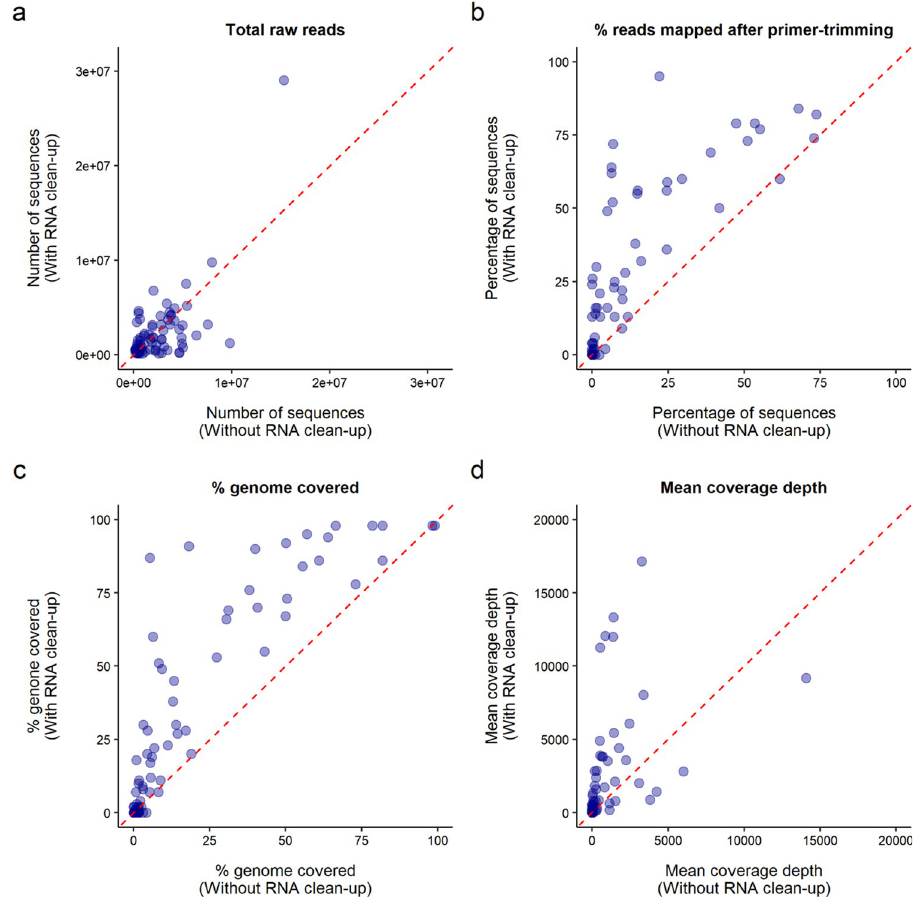
Fig 2. RNA clean-up resulted in improved library preparation and sequencing. Sequencing and alignment data, including total number of raw reads (a), percentage of raw reads mapping to SARS-CoV-2 genome after primer- trimming (b), percentage coverage breadth (c) and mean coverage depth (d), for each sample sequenced with or without the RNA clean-up step. Red line delineates x = y.